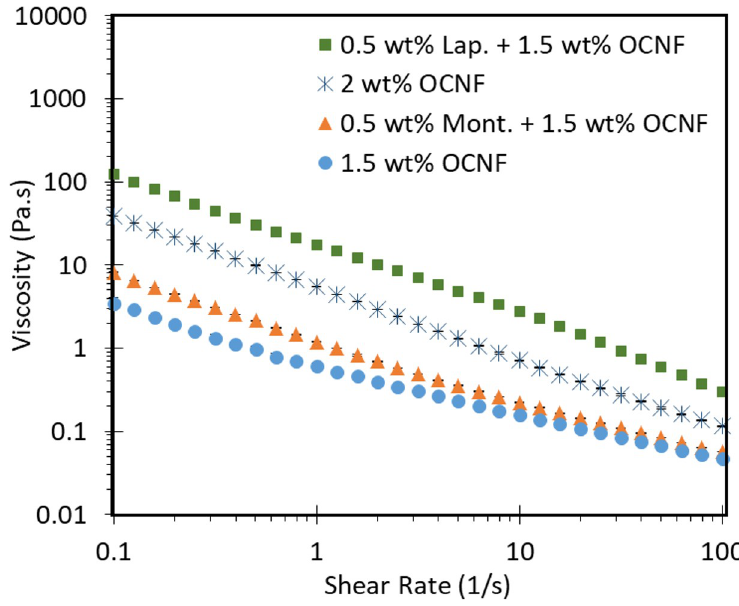
Fig 3. Flow sweeps of OCNF and clays. Flow sweep curves of 2 wt% OCNF (blue crosses), 1.5 wt% OCNF (blue circles), and 1.5 wt% OCNF with 0.5 wt% of either Laponite (green squares) or montmorillonite (orange